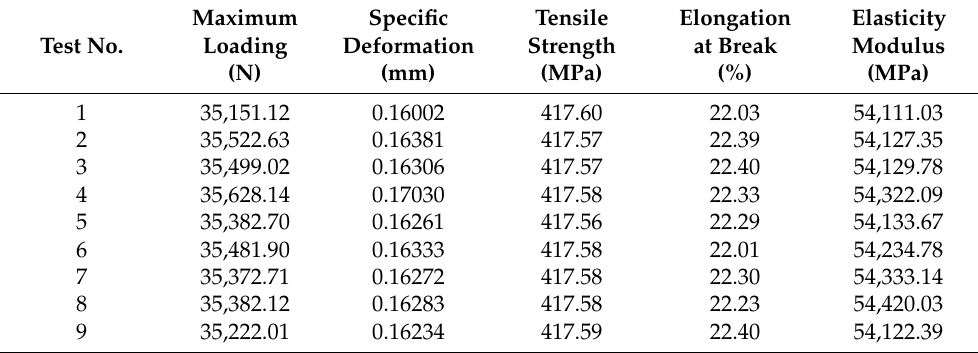
Table 2. Results of tensile tests on EN-GJS-400-15 spheroidal graphite cast iron testing samples.